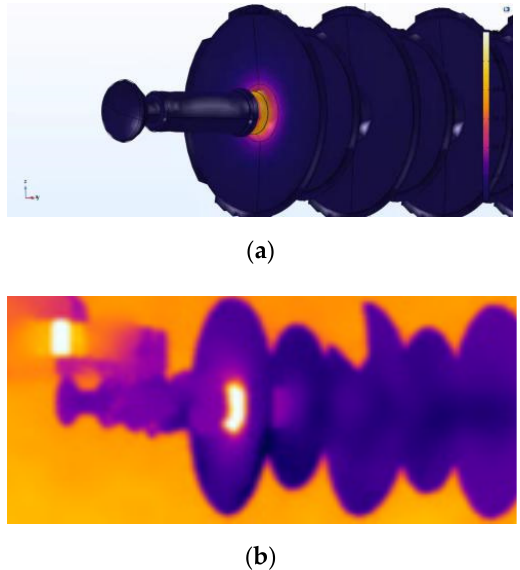
Figure 9. Simulation results and field infrared comparison map: ( a ) simulation results of sample #1 electrothermal coupling; ( b ) temperature rise image of sample #1 at 95% Humidity. Table 5. Electrical and thermal characteristic values of the used parameters. Parameters